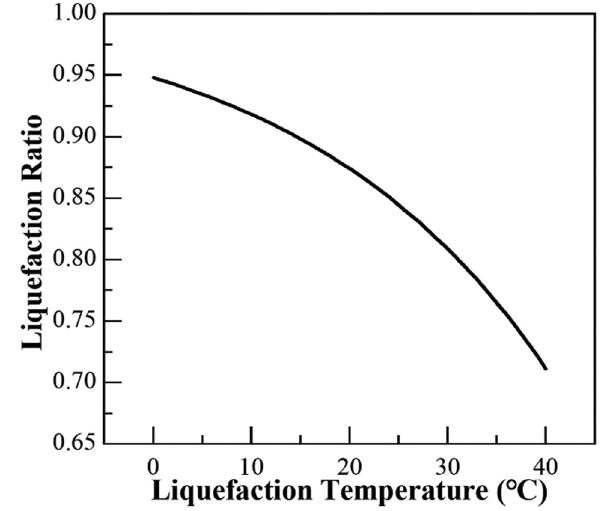
Figure 4: Relationship between the extraction dosage and the IS yield.